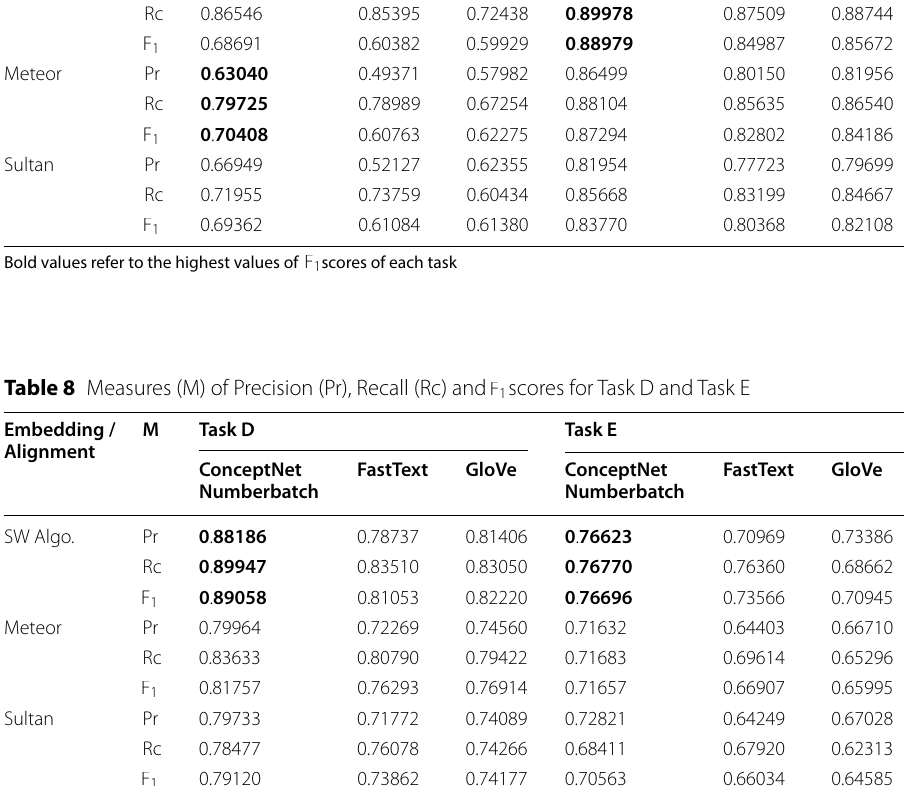
Table 7 Measures (M) of Precision (Pr), Recall (Rc) and F 1 scores for Task B and Task C Embedding / M Task B Task C Alignment ConceptNet FastText GloVe ConceptNet Numberbatch Numberbatch SW Alg.